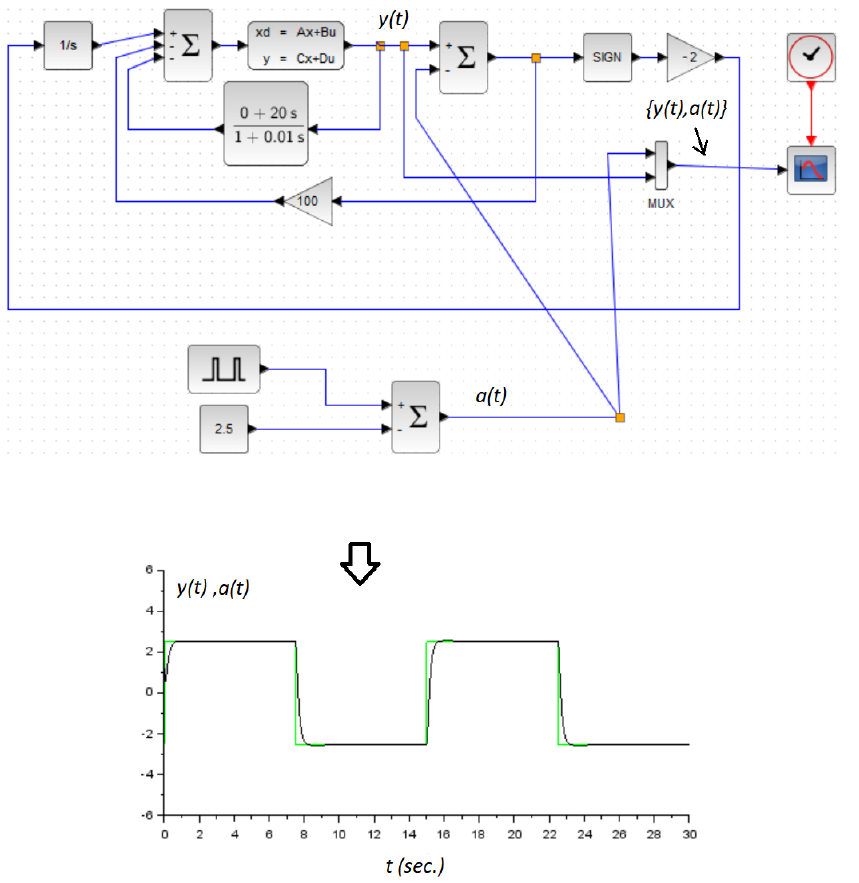
Figure 5. Numerical example: A pulse reference signal case. The green line is the reference signal a ( t ) , and the black line is the system response y ( t )